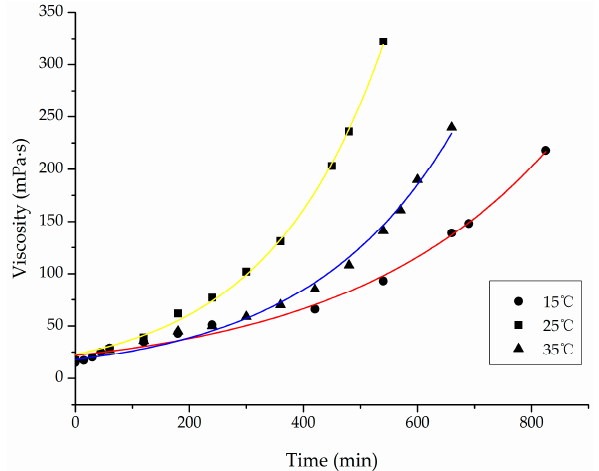
Figure 2. The viscosity-temperature-time curve of CW 5:1 slurry.